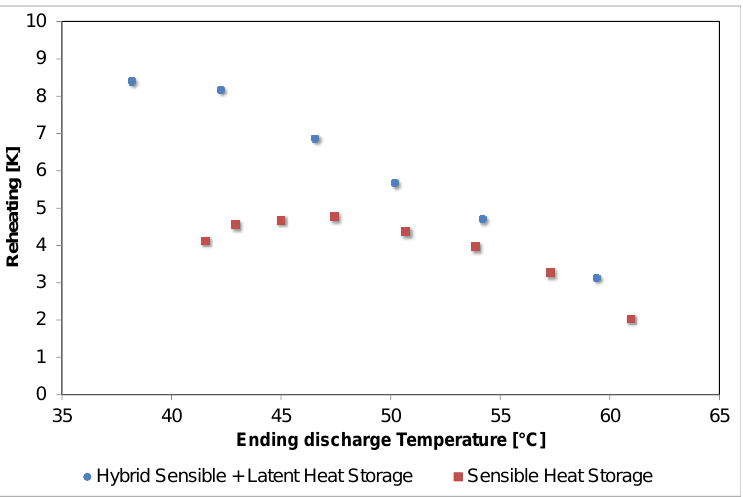
Figure 9. Difference in reheating effect measured obtained for the sensible and hybrid TES configu- rations during analogous Test A.